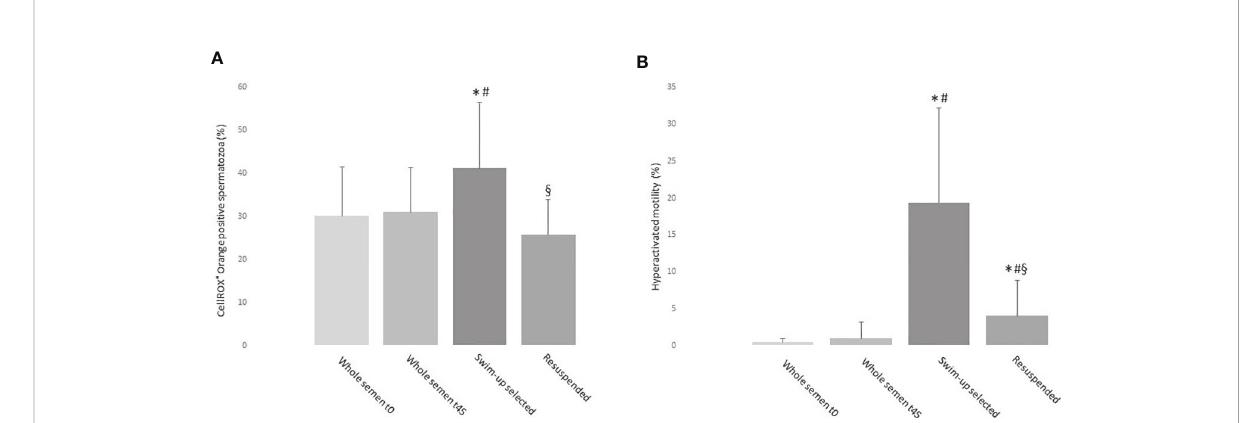
FIGURE 10 Histograms representing the mean values ( ± sd) of the percentages of CellROX ® Orange positive spermatozoa ( A , n=11) and hyperactivated motility ( B , n=11) of whole semen at time zero (t0) and after 45 minutes at 37°C (t45), swim-up selected samples and swim-up selected spermatozoa then resuspended with the lower phase. *p<0.05 vs. whole semen t0; # p<0.05 vs. whole semen t45; § p<0.05 vs. swim-up selected sample.